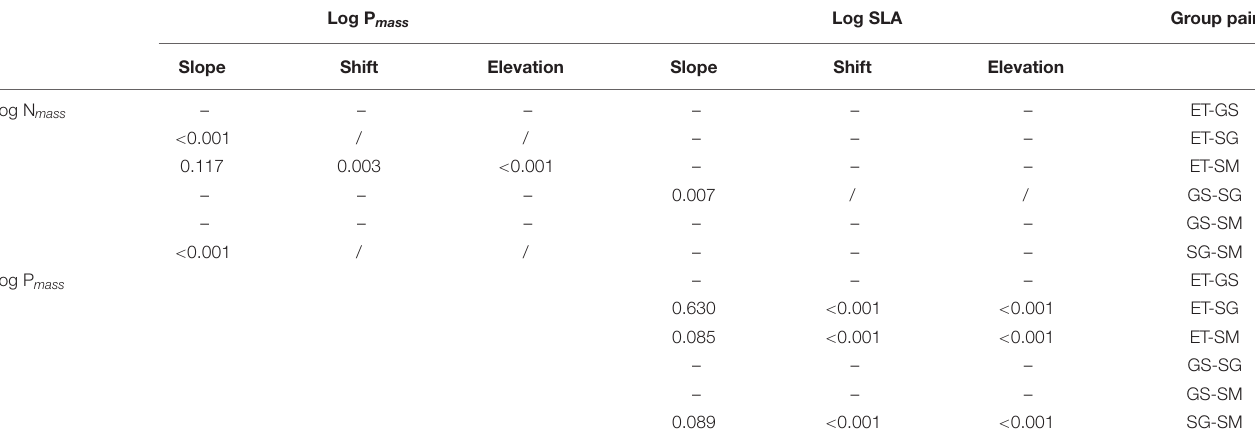
TABLE 2 | The multiple comparisons of the trait-trait correlations between every two plant groups. Log P